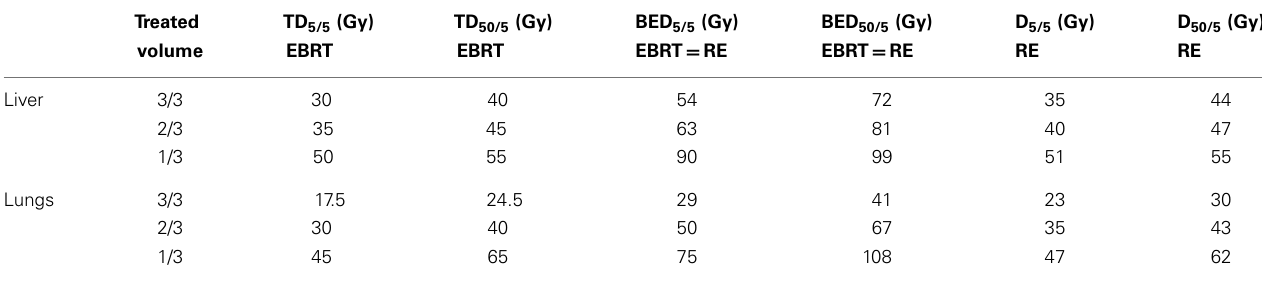
Table 3 | Mathematical example of tolerance doses derived from EBRT assuming a uniform dose distribution to liver and lungs